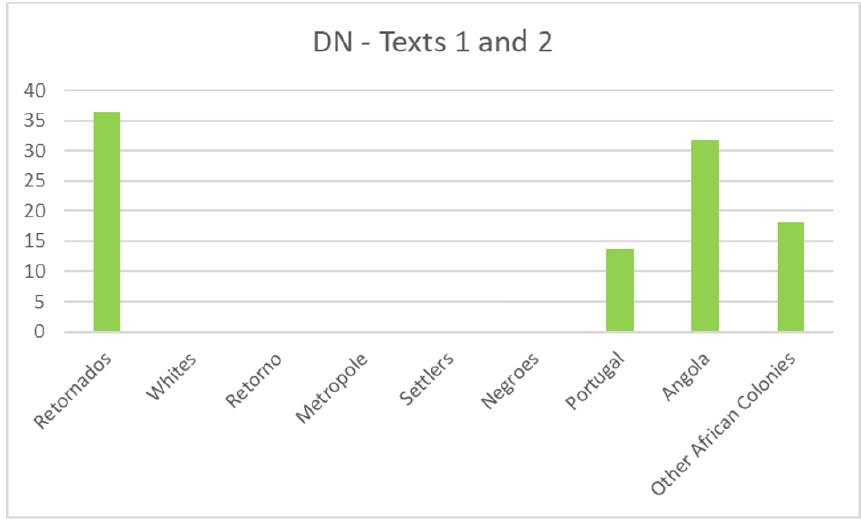
Figure 13. Most prominent words in the sum of the two texts of the Diário de Notícias.